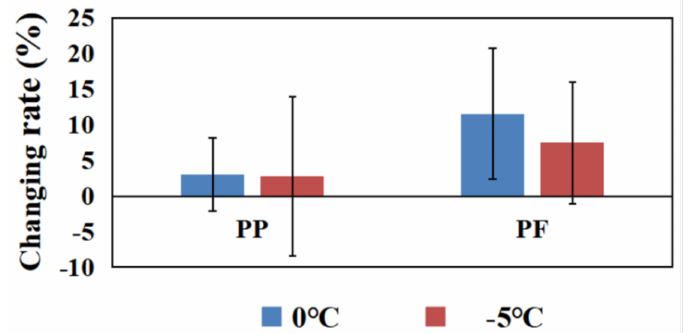
Figure 4. The changing rates of PP and PF in the 0 ◦ C and − 5 ◦ C groups. Note: * means that there are significant differences between Before and After in peak power in the 0 ◦ C